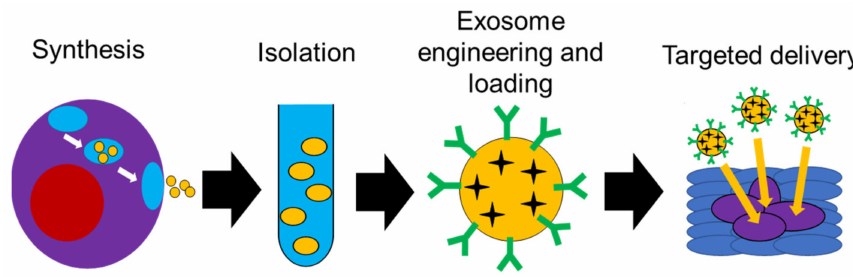
Figure 4. Schematic diagram showing possible use of exosomes in targeted